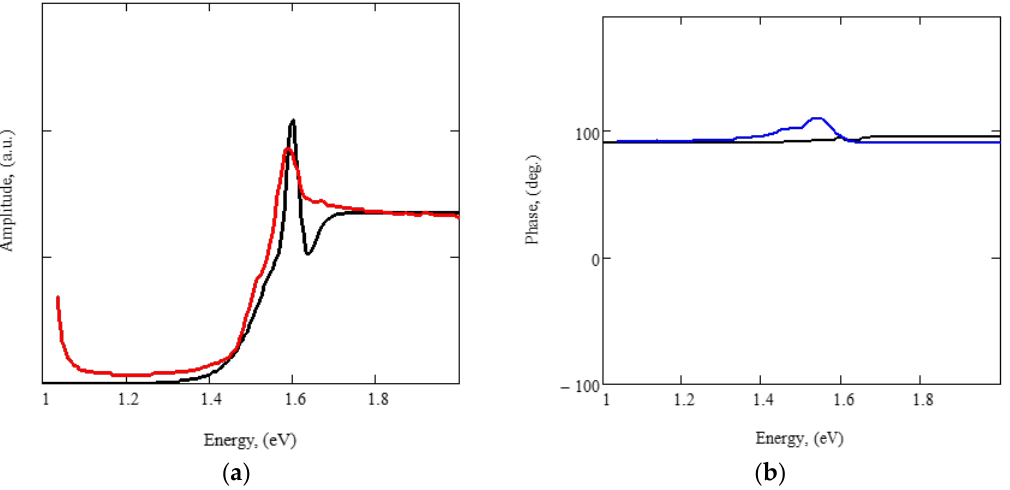
Figure 10. Amplitude ( a ) and phase ( b ) spectra of the etched Cd 0.95 Be 0.05 Te mixed crystal for 126 Hz modulation frequency. Simulated spectra are presented by black lines, experimental amplitude by red lines, and experimental phase by blue lines.